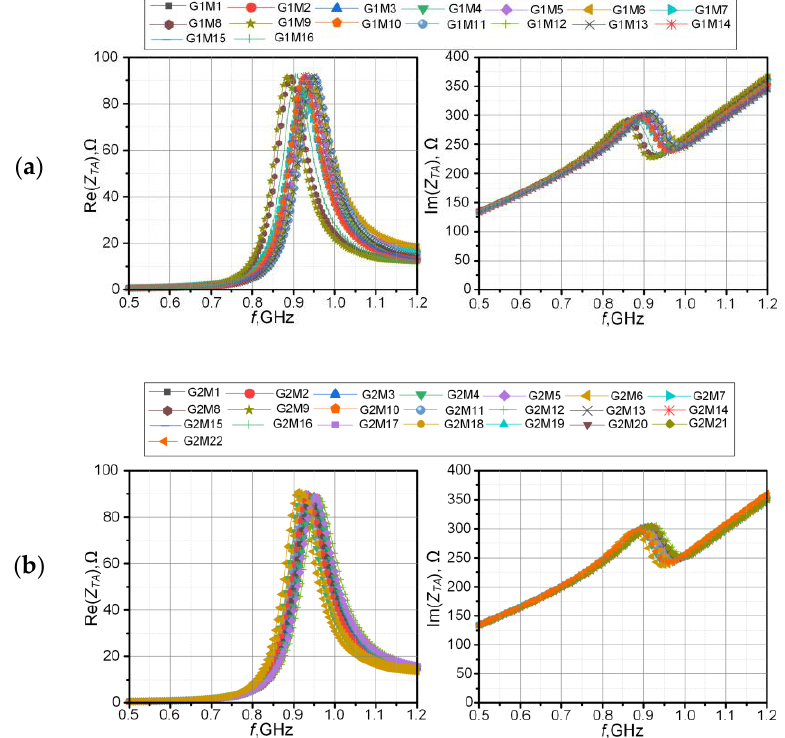
Figure 15. Model of RFIDtex transponder in EMCoS Studio: ( a ) definition of infinitive dielectric substrates; ( b ) model of dielectric substrates; ( c ) model completed with conductive components.